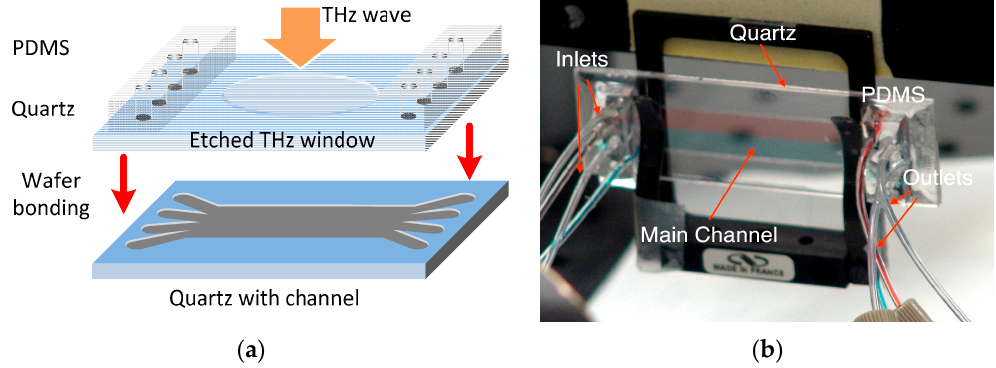
Figure 2. ( a ) The fabrication of the quartz-based microfluidic device using wafer bonding; ( b ) A two-stream laminar flow (with red and blue dyes at an injection rate of 100 μ L/min) formed inside the device main channel demonstrating that the design and fabrication of the device were